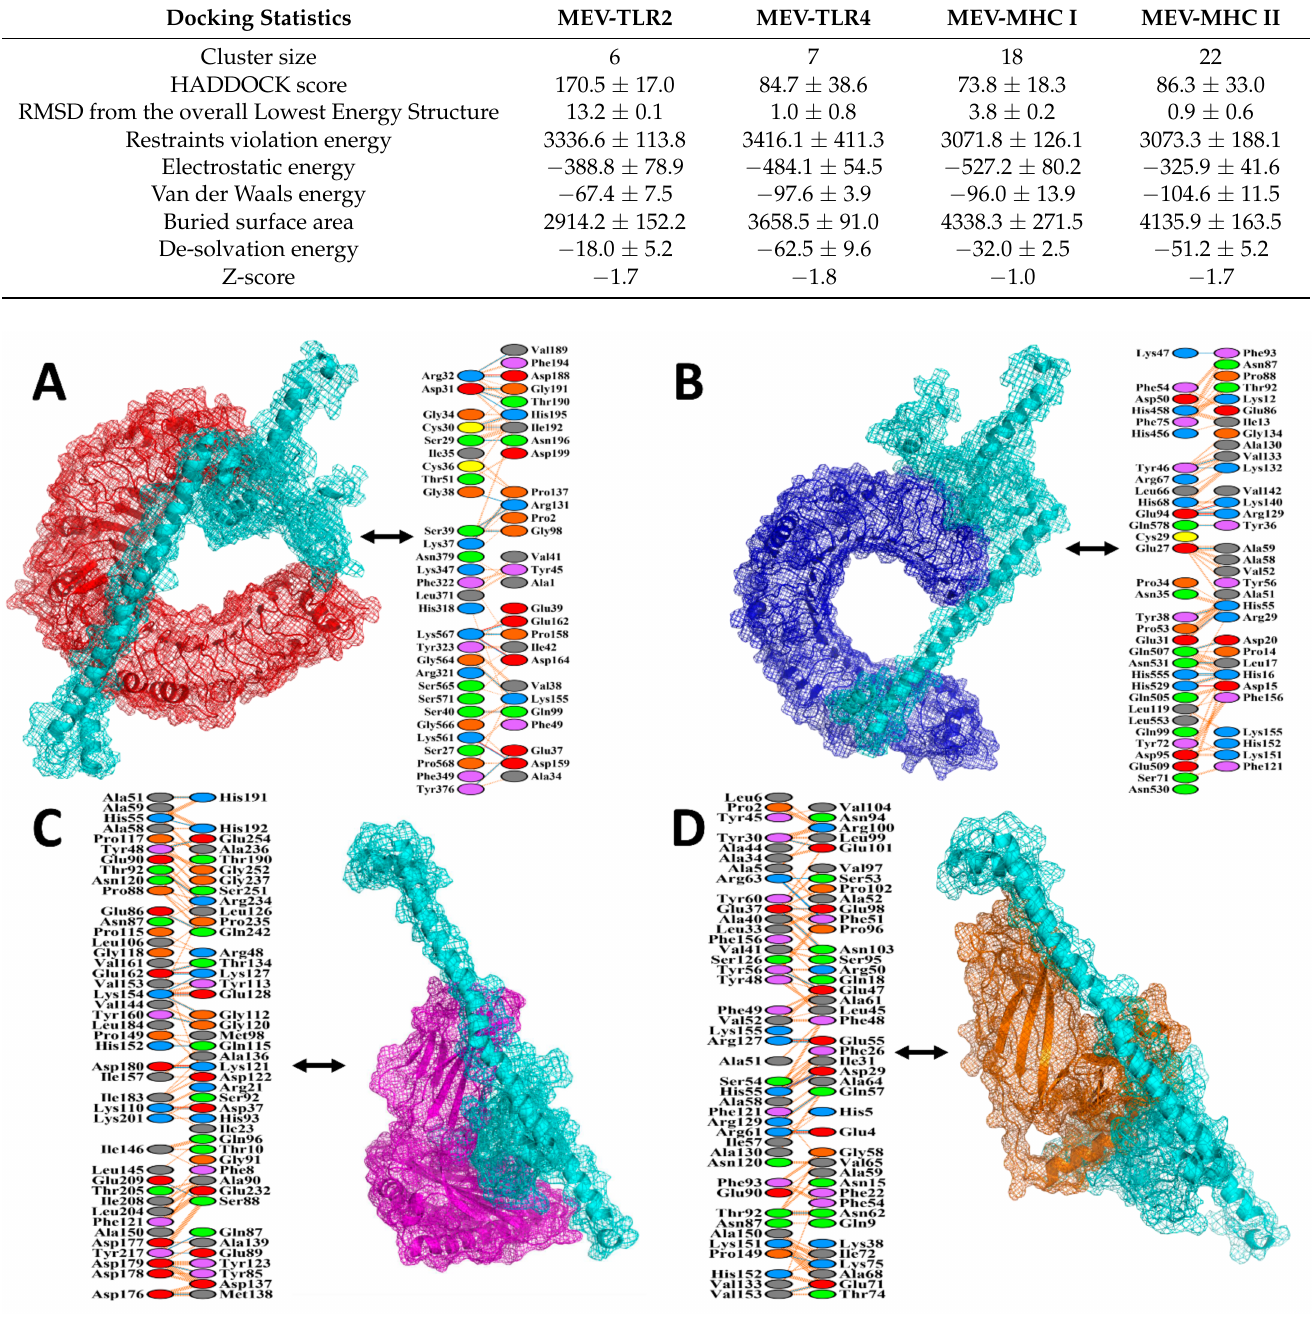
Figure 3. MEV–immune receptors binding conformation and interaction analysis. Intermolecular binding mode and residue level chemical interactions of ( A ) MEV-TLR2; ( B ) MEV-TLR4; ( C ) MEV-MHC I; ( D ) MEV-MHC II. The MEV is shown in cyan mesh, whereas TLR2, TLR4, MHC I, and MHC II are presented via mesh firebrick, blue, magenta, and sienna,